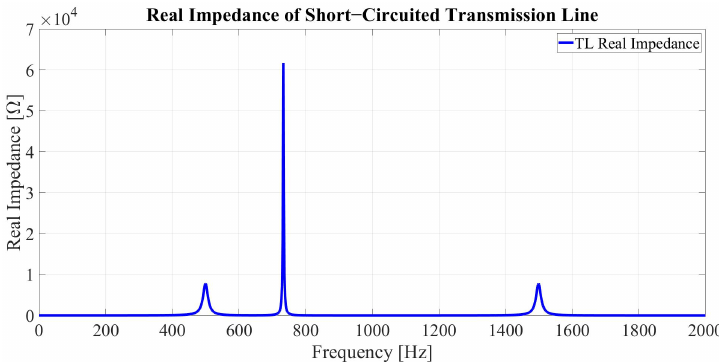
Figure 3. Frequency response measurements of transmission line imaginary impedance.